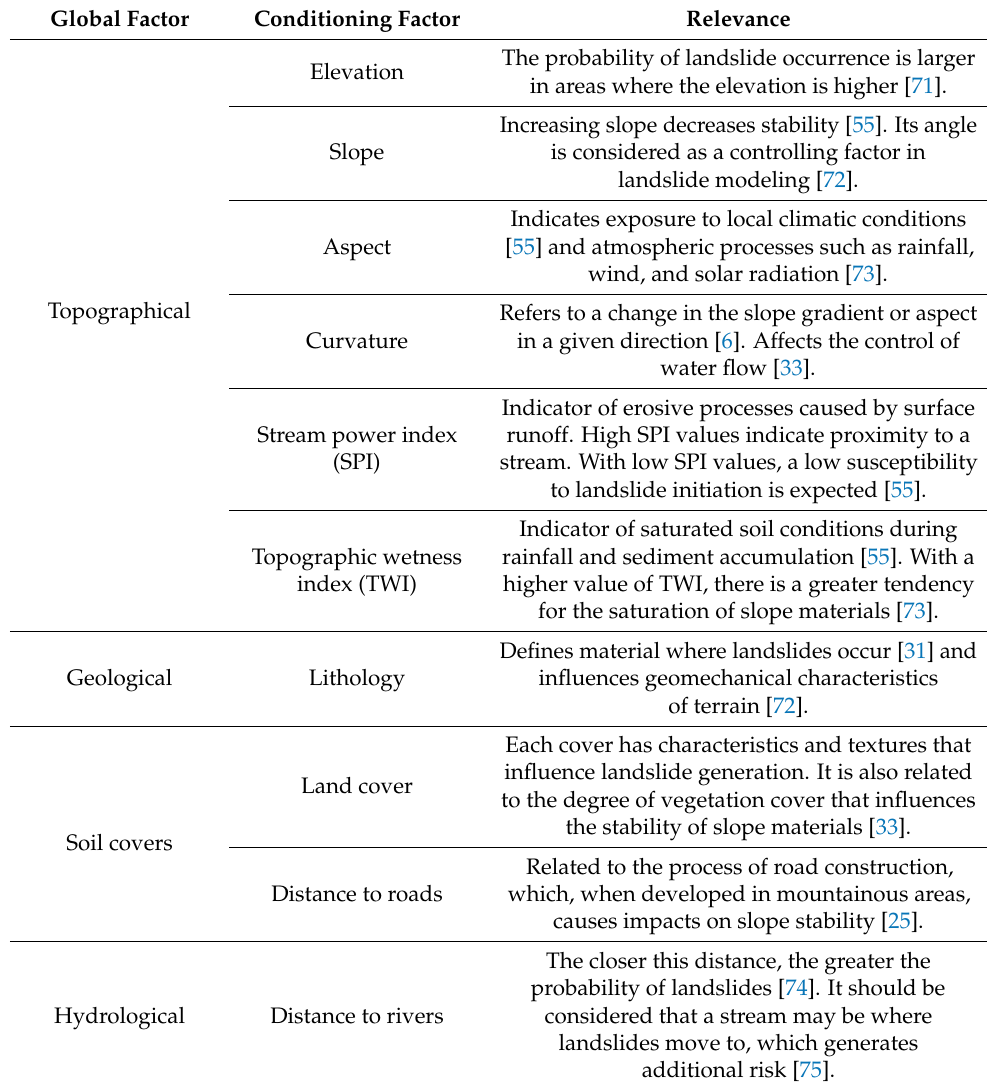
Table 3. Important characteristics of conditioning factors used in this research according to land- slide